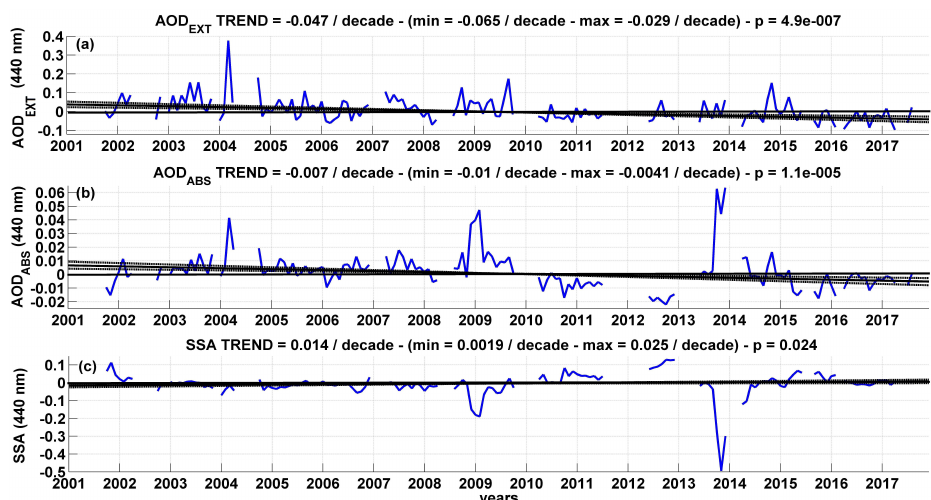
Figure 5. Trend analysis of: ( a ) AOD EXT ( λ = 440 nm), ( b ) AOD ABS ( λ = 440 nm), and ( c ) SSA ( λ = 440 nm) retrieved from columnar measurements, at the site of Rome Tor Vergata, from January 2001 to August 2017, using the Mann-Kendall test associated with Sen’s slope. The solid black lines in the test result show the linear trend and the 90% confidence interval of the estimated Sen’s slope. AERONET Version 2 Level 2.0* data inversion products were used.